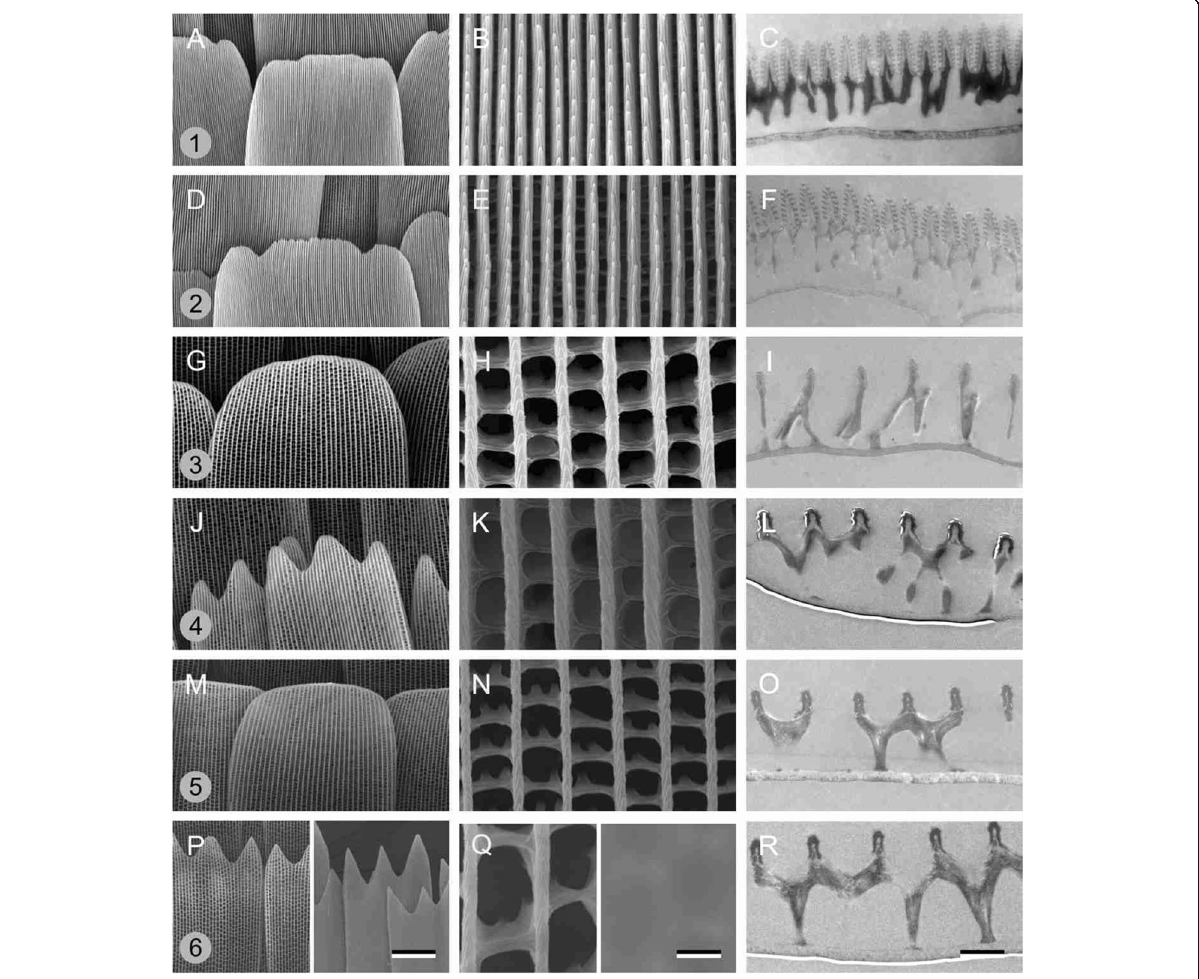
Fig. 2 Electron micrographs of various wing scales. a - c Blue scales. d - f White scales. g - i Orange-yellow scales. j - l Red scales. m - o Brown scales. a - o Dorsal wing scales. p - r Greenish ventral wing scales. Left and middle columns: scanning electron microscopy ( p and q left half: from the abwing side; right half: from the adwing side), right-hand column: transmission electron microscopy; scale bars: 20 μ m (left column), 2 μ m (middle and right columns). The numbers 1 – 6 in a , d , g , j , m , and p correspond to the numbered areas in Fig. 1b,